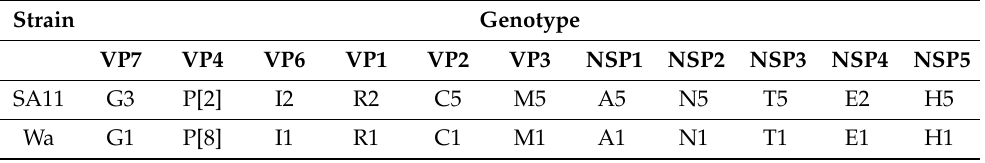
Table 1. Segment-specific genotypes of SA11 and Wa genome segments.